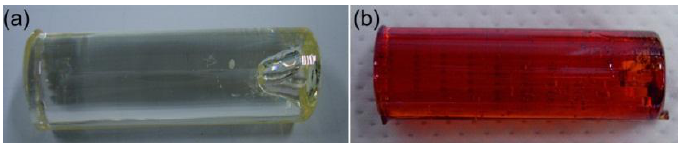
Figure 2. Optical photograph of tellurite glass rods with 16 mm outer diameter (OD): ( a ) 75TeO -20ZnO-4Na O-2NaCl (TZNX). ( b ) 60TeO 2 2